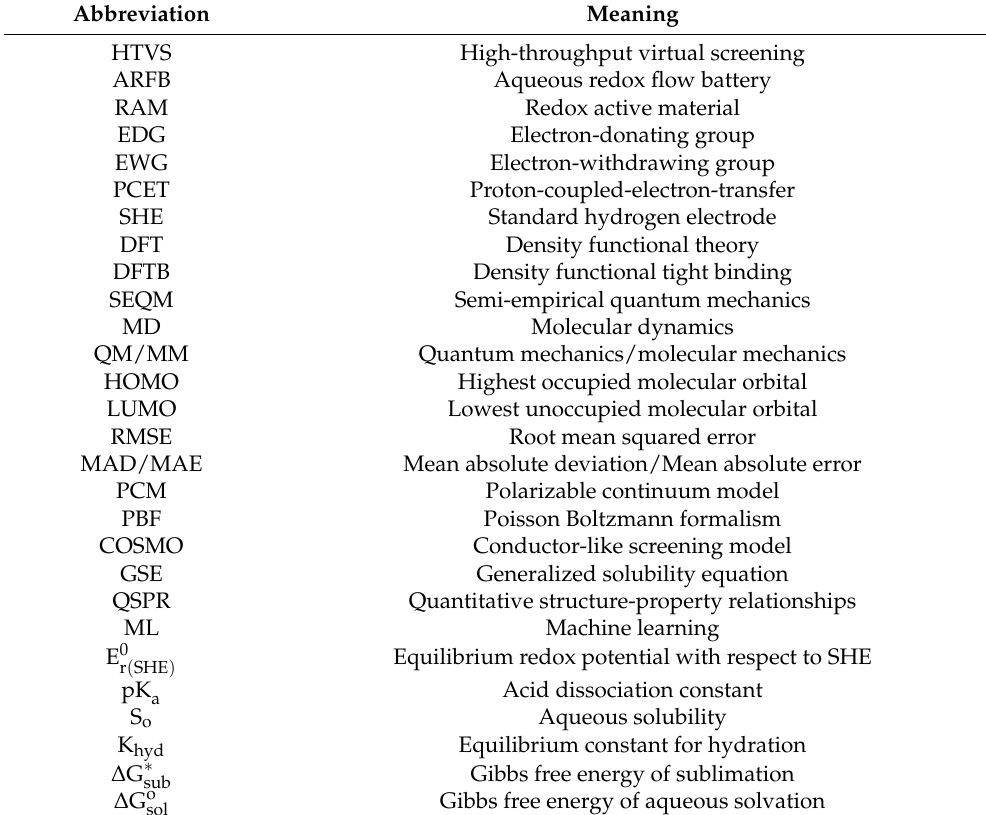
Table 2. List of abbreviations and mathematical symbols and their